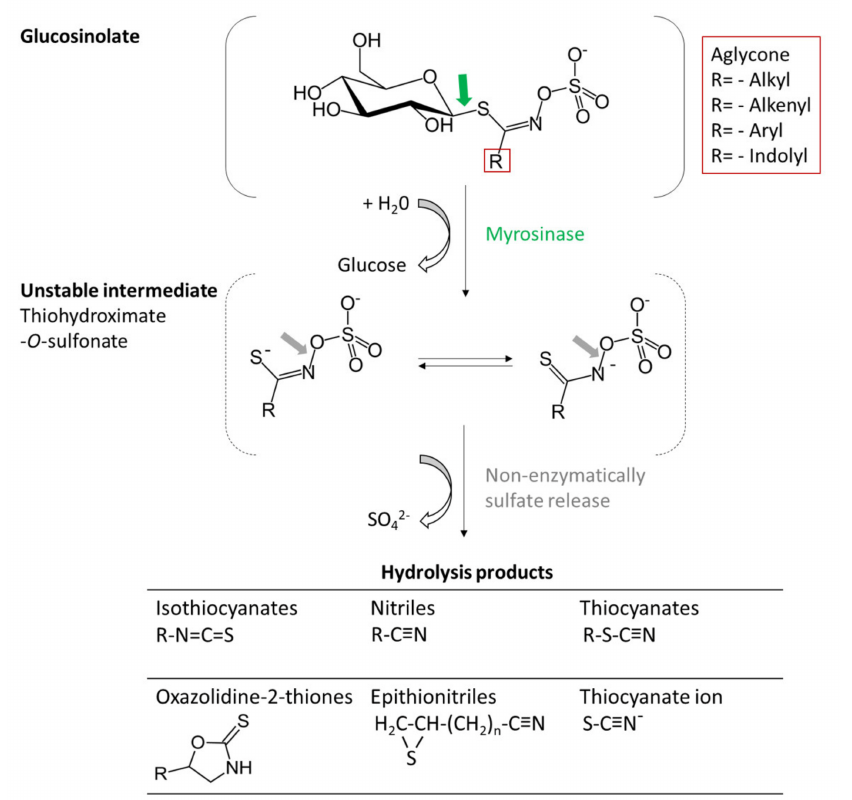
Figure 2. Enzymatic processing of glucosinolates by myrosinase into hydrolysis